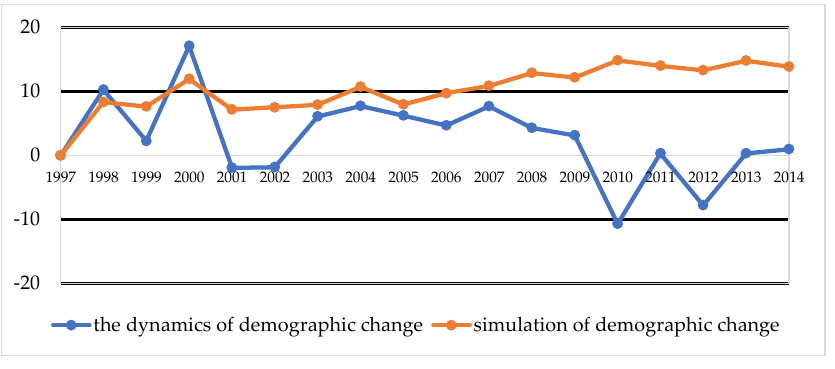
Figure 6. The dynamics of demographic change in Olsztyn in the years 1997 – 2014. Source: own study based on CSO, EUROSTAT, LSD [24 – 28,36].